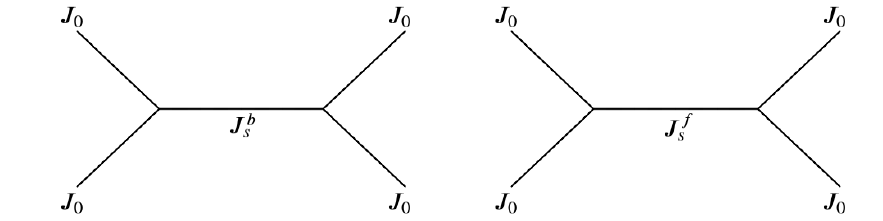
Figure 6 . Schematic for the exchanges relevant in the supersymmetric scalar